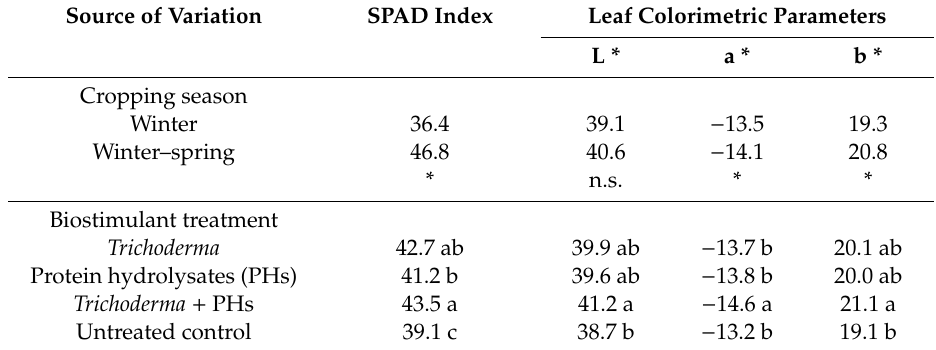
Table 2. Cropping season and biostimulant e ff ect on perennial wall rocket SPAD (soil plant analysis development) index and leaf colorimetric